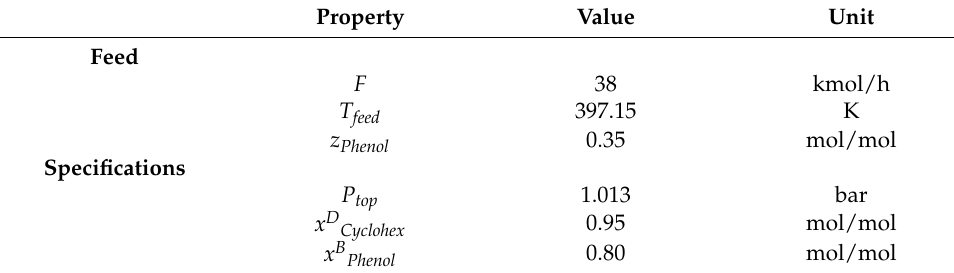
Table 2. Distillation feed properties and nominal operating